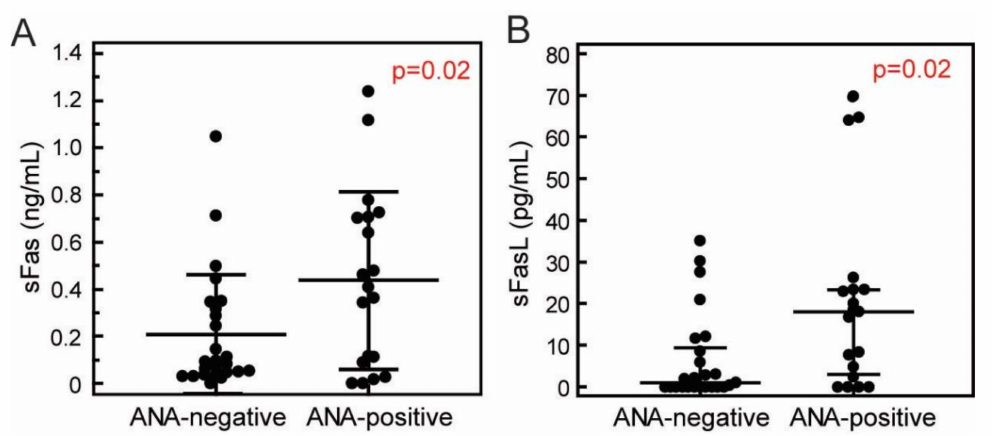
Figure 5. Concentrations of the sFas ( A ) and sFasL ( B ) in the sera of ANA-positive ( N = 19) and ANA-negative ( N = 25) patients with RRMS. Concentrations were measured using cytometric bead-based arrays (LEGENDplex, Biolegend). ANA positivity was determined using HEp-2 IIF test (EUROIMMUN). Markers, individual patients’ values, horizontal lines and bars, mean ± SD ( A ) or median ± IQR ( B ); p values, t -test ( A ) or Mann-Whitney test ( B